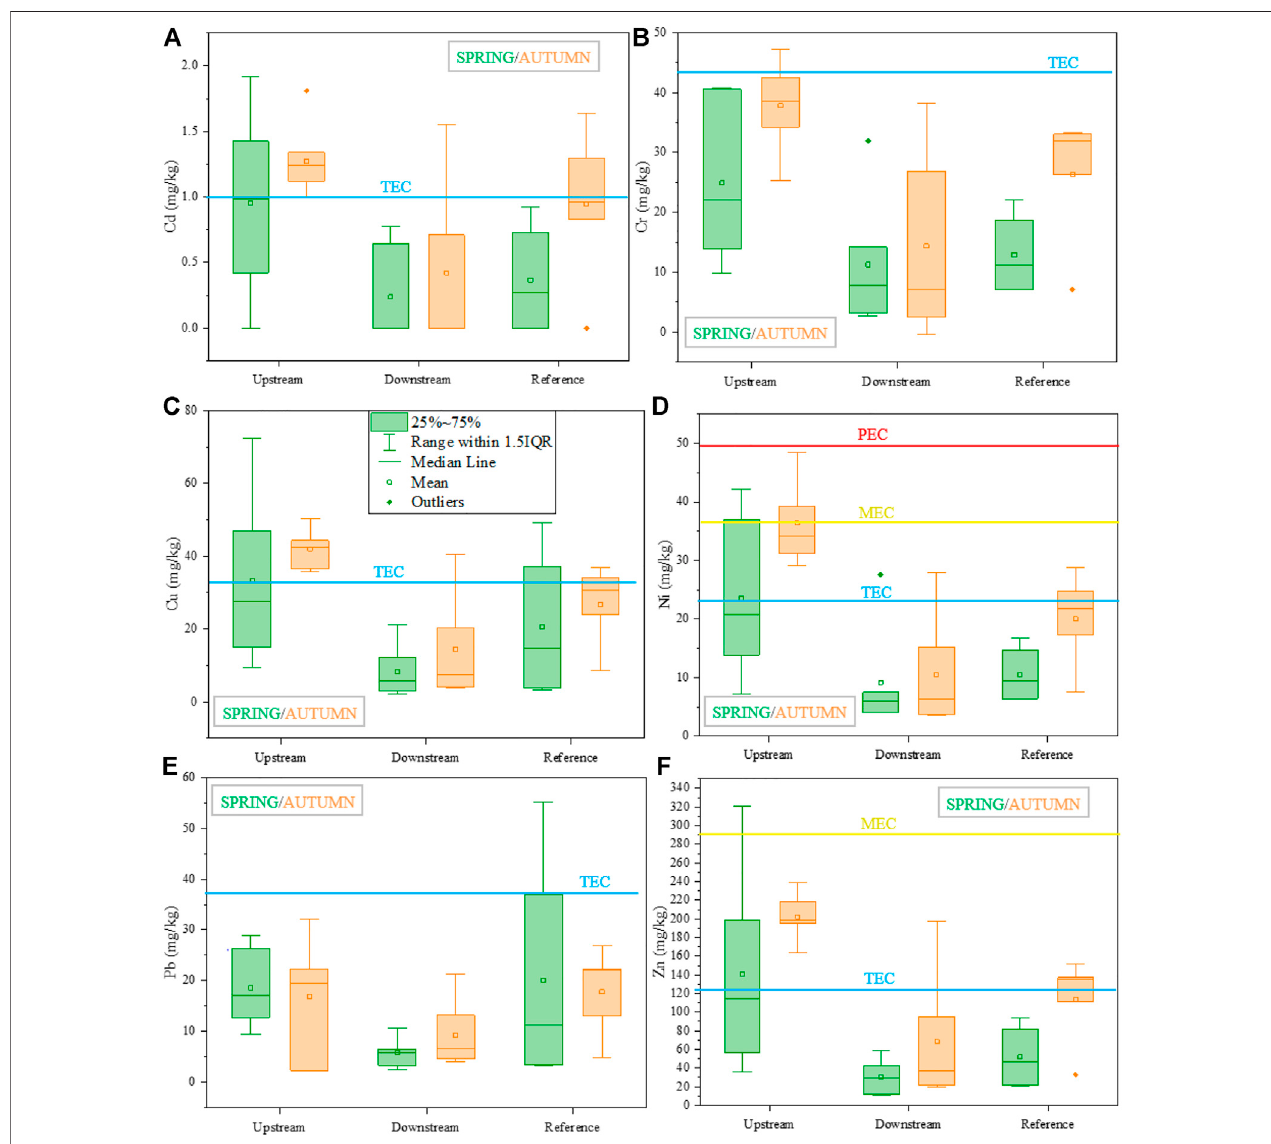
FIGURE 9 | (A – F) . Cd, Cr, Cu, Ni, Pb and Zn values in the sediment from the Bystrzyca River at the studied measuring